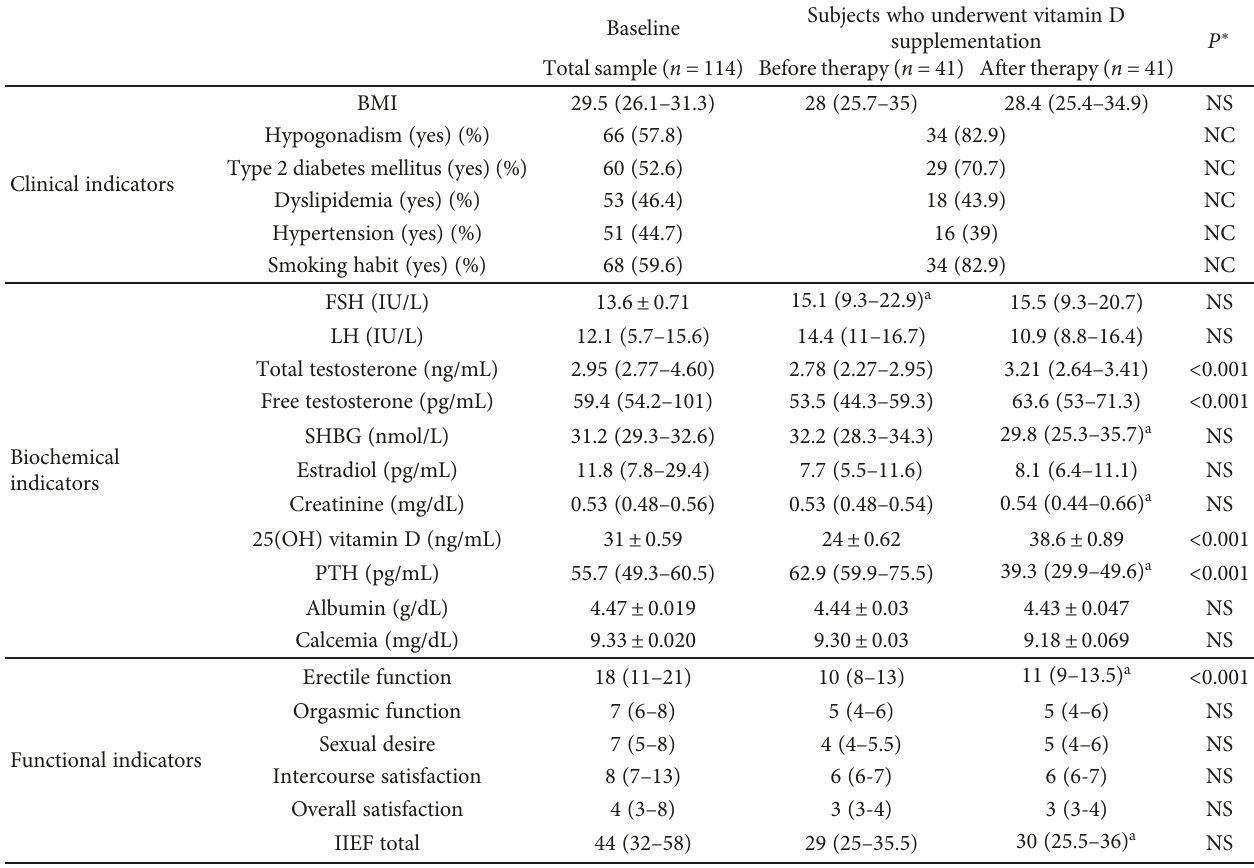
Table 1: Clinical, hormonal, and sexual characteristics of the studied sample at baseline and after vitamin D replacement therapy.